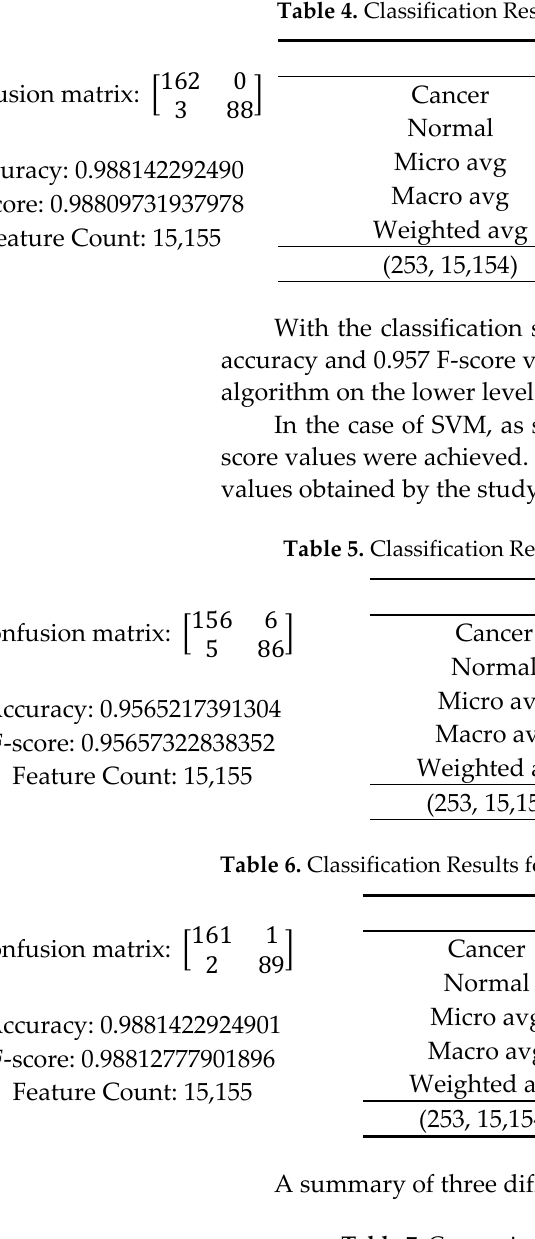
Table 7. Comparison of SVM, DT and